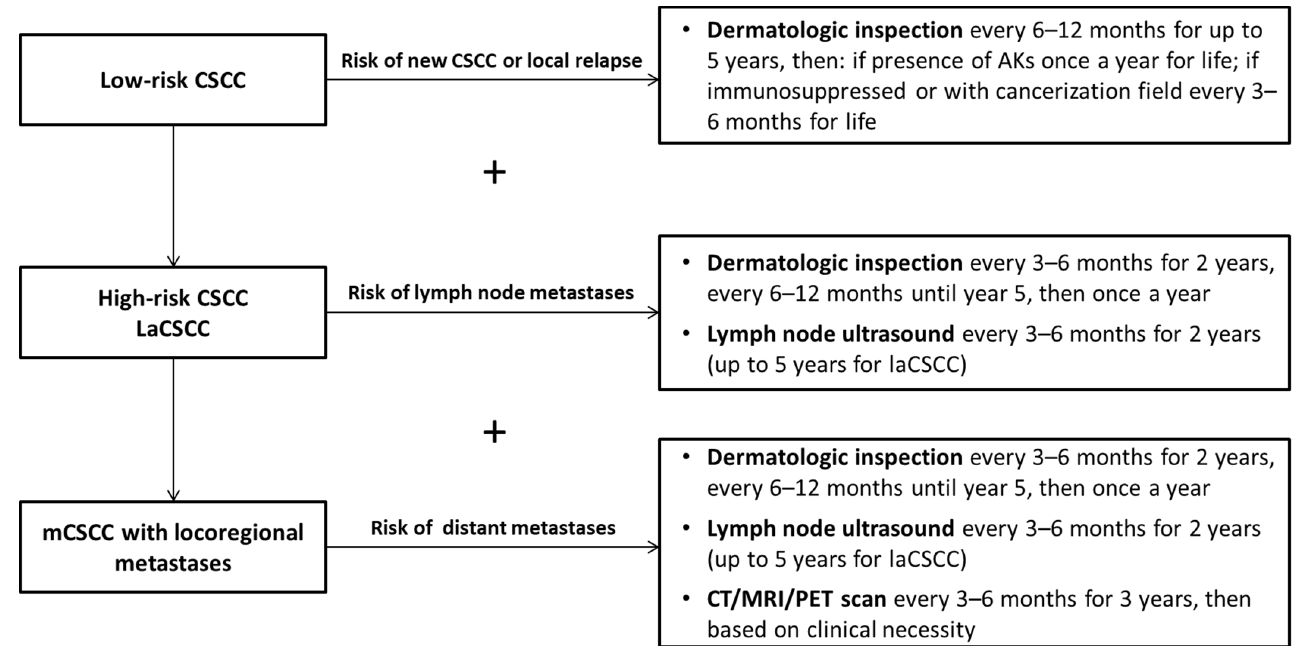
Figure 2. Algorithm for the follow-up of patients with cutaneous squamous cell carcinoma. Derma- tologic inspection should always include lymph node palpation. Clinical evaluation and imaging should be tailored to patient life expectancy and comorbidities. Additional exams may be necessary according to symptoms or clinical suspect. Abbreviations: AK: actinic keratosis; CSCC: cutaneous squamous cell carcinoma; laCSCC: locally advanced cutaneous squamous cell carcinoma; mCSCC: metastatic cutaneous squamous cell carcinoma.